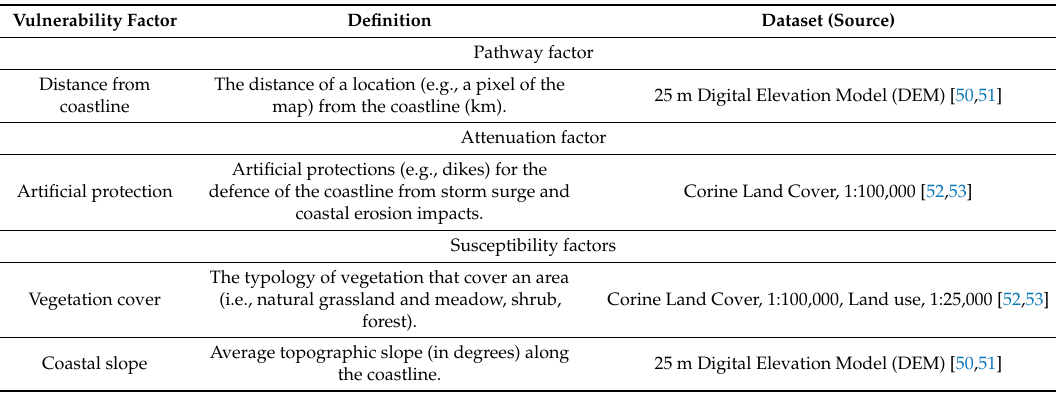
Table 3. Dataset used for the implementation of the regional risk assessment methodology in the NA study area. The acronym FVG means Friuli Venezia Giulia, ISPRA means High Institute for Environmental Protection and Research. Adapted from